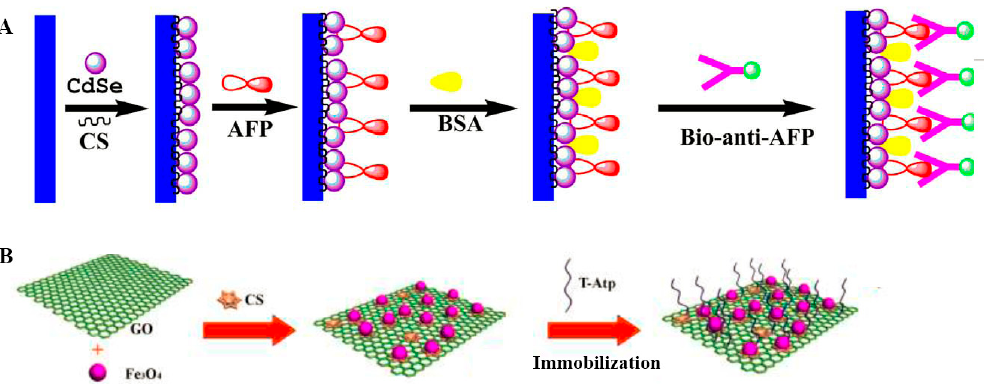
Figure 2. ( A ) Quantum dots (QDs) acted as biocompatible matrices for the immobilization of alpha fetoprotein (AFP) and photoactive materials to increase the photoelectrochemical (PEC) signals. ( B ) Chitosan-modified magnetic oxide graphene composite (CS@Fe 3 O 4 @GO) worked as supporting matrices for thrombin aptamer. Reproduced from [37,42] with permission from Elsevier.